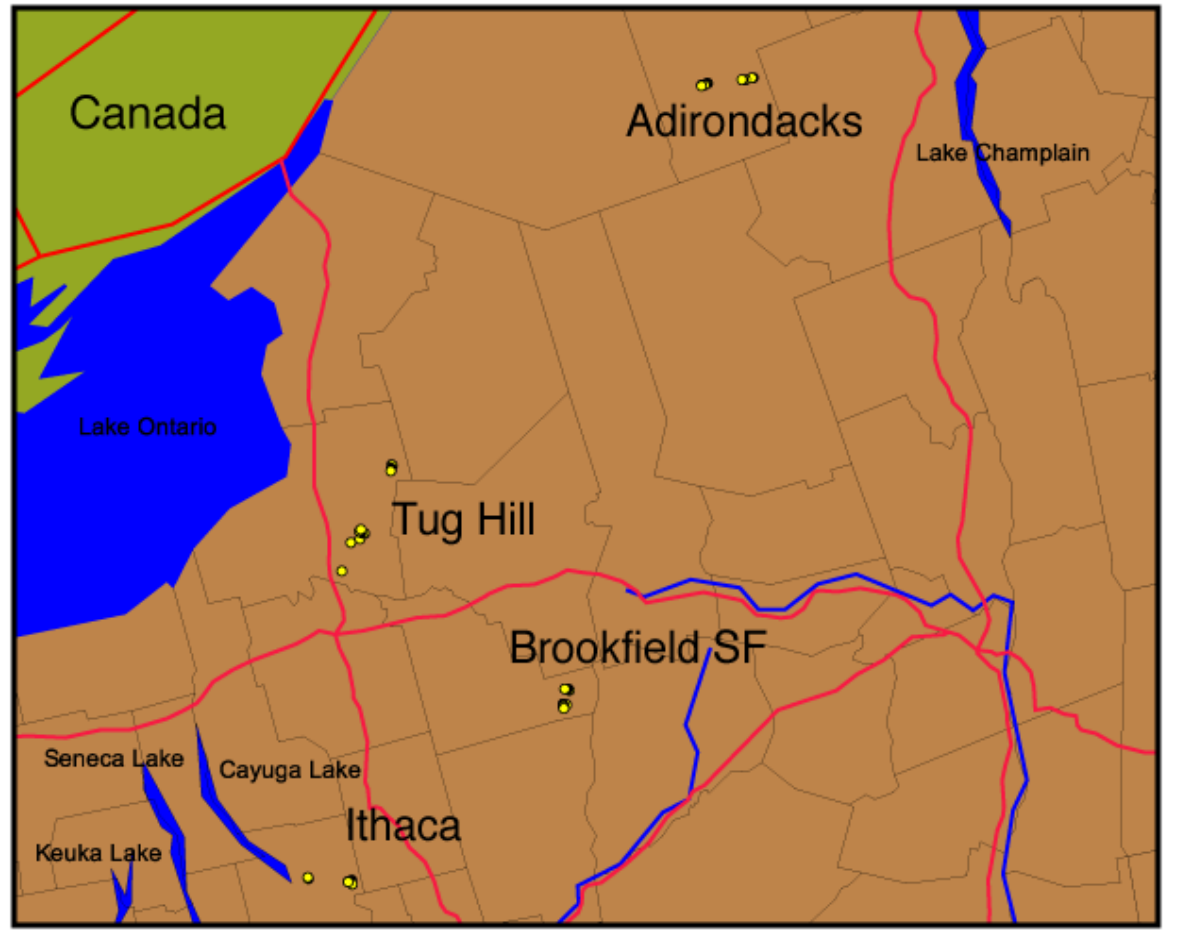
Fig. 2. Map showing the location of 40 study sites in New York. Sites were selected in four areas, i.e., the Adirondacks, the Tug Hill Plateau, the Finger Lakes region, and the Brookfield area in the Reforestation District, south of Utica. These all differed in geological parent material, soil properties, and estimated wet acidic deposition using maps. Within each area, two groups of five sites were placed in two widely separated locations to further ensure that a range of soil properties were